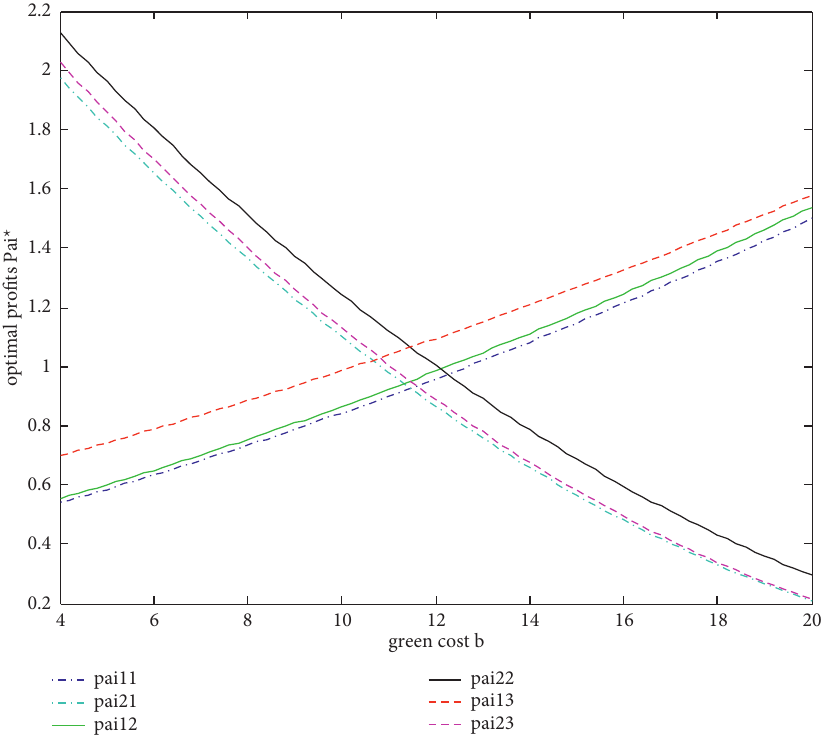
Figure 7: Optimal profits with green